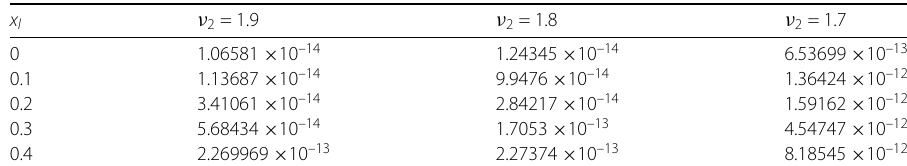
Table 4 Residual error E 10 at ν 2 = 1.9,1.8,1.7 for Example 4